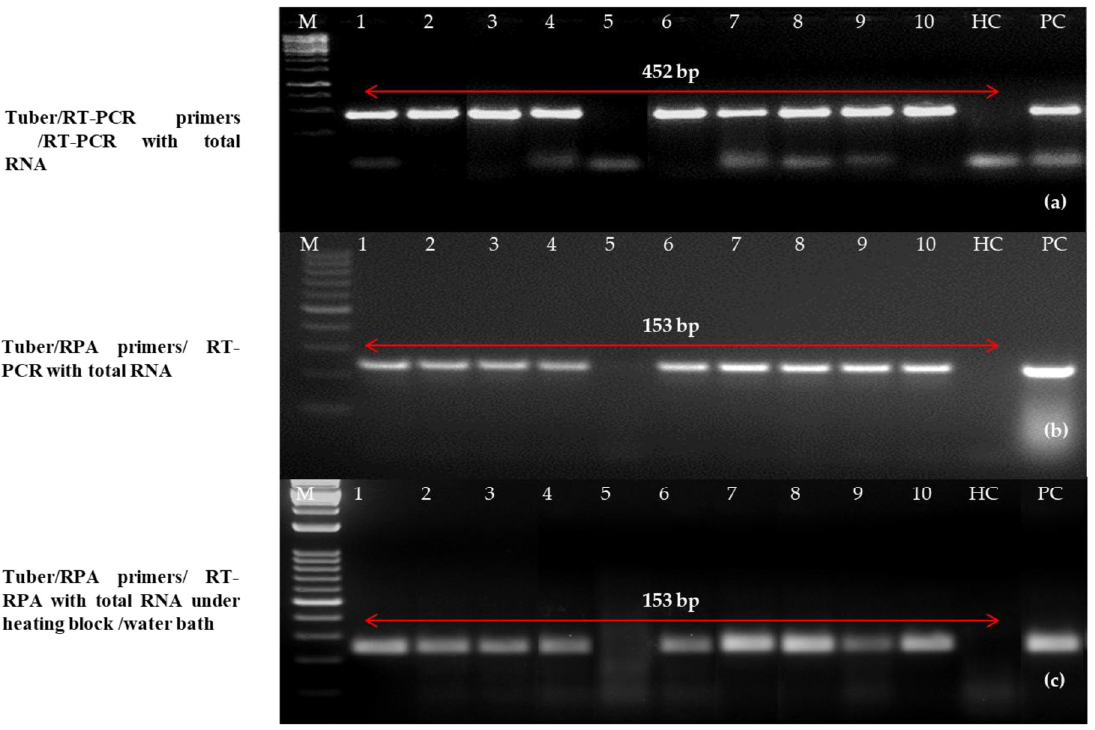
Figure 9. Optimization of reverse-transcription recombinase polymerase amplification/reverse transcription-polymerase chain reaction (RT-RPA/RT-PCR) for successful detection in potato leafroll virus (PLRV) infected tubers. ( a ) One-step RT-PCR performed with previously reported primers [12] on purified RNA; ( b ) one-step RT-RPA with newly optimized primer LRRPAF3/R3 on purified total RNA; ( c ) one-step RT-RPA with optimized primer LRRPAF3/R3 on cellular disc-mediated RNA extract. Lane M ( a – c ): 50 bp DNA ladder, lanes 1–15: potato leaf samples, PC: known